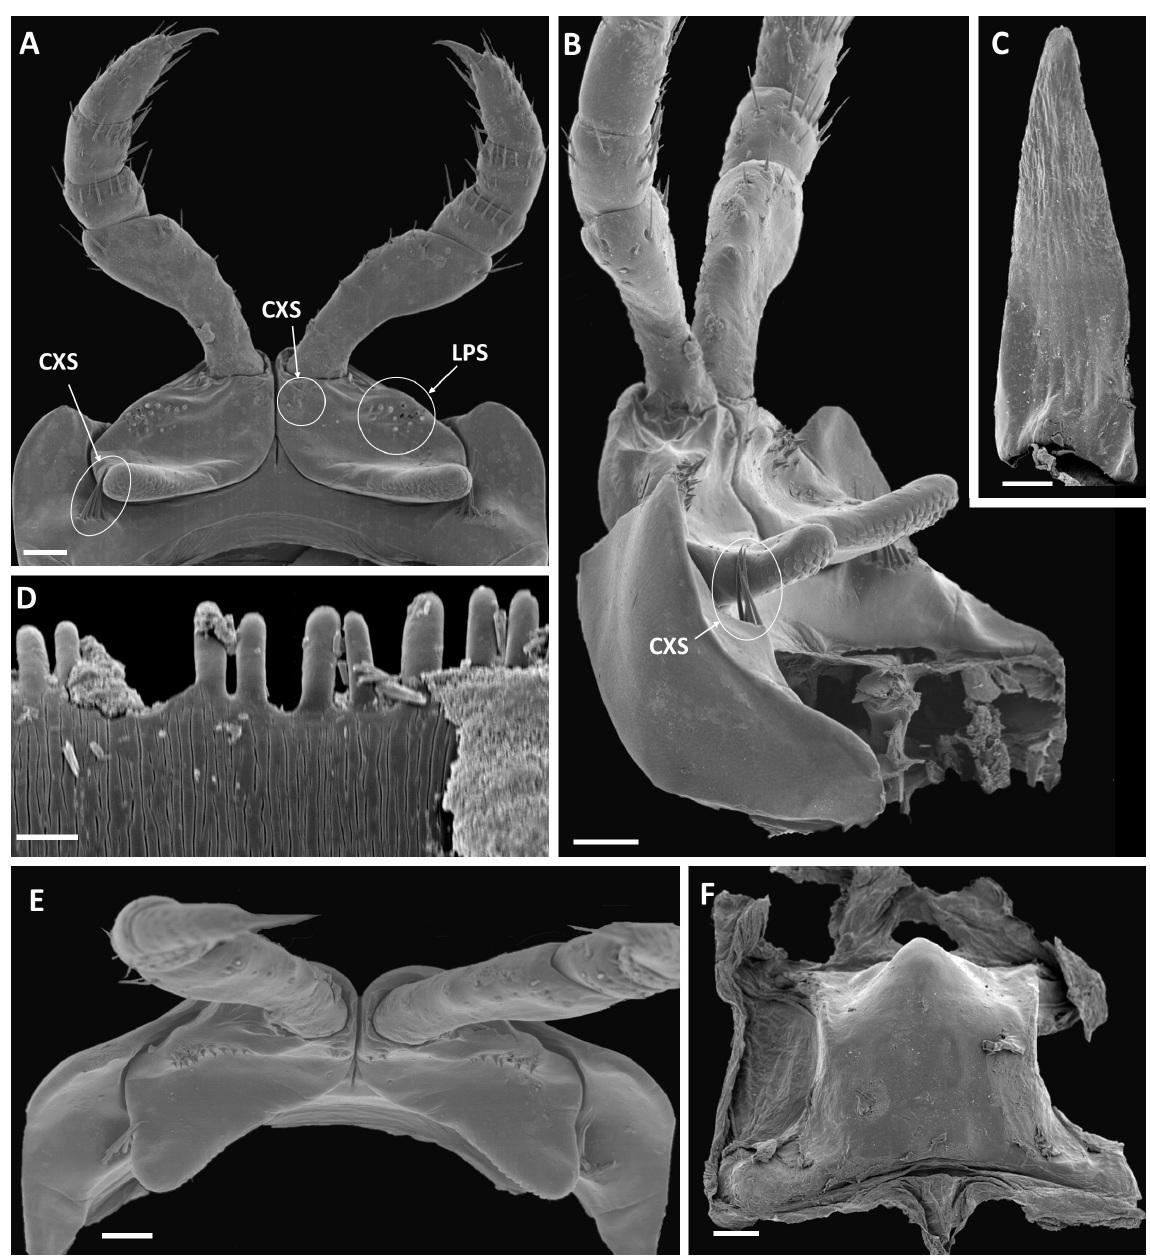
Fig. 66. Xystopyge doggartae sp. nov., holotype, ♂ (NHMD 621768). A–B, E . First pair of legs. A. Anterior view. B. Sublateral view. E. Ventral view. C . Gonopod sternum (sternum 8). D . Midbody dorsal limbus. F . Sternum 9. Abbreviations: APS = mesapical prefemoral sensilla; CXS = coxosternal setae; LPS = lateral prefemoral sensilla. Scale bars: A–C, E–F = 0.1 mm; D = 0.005